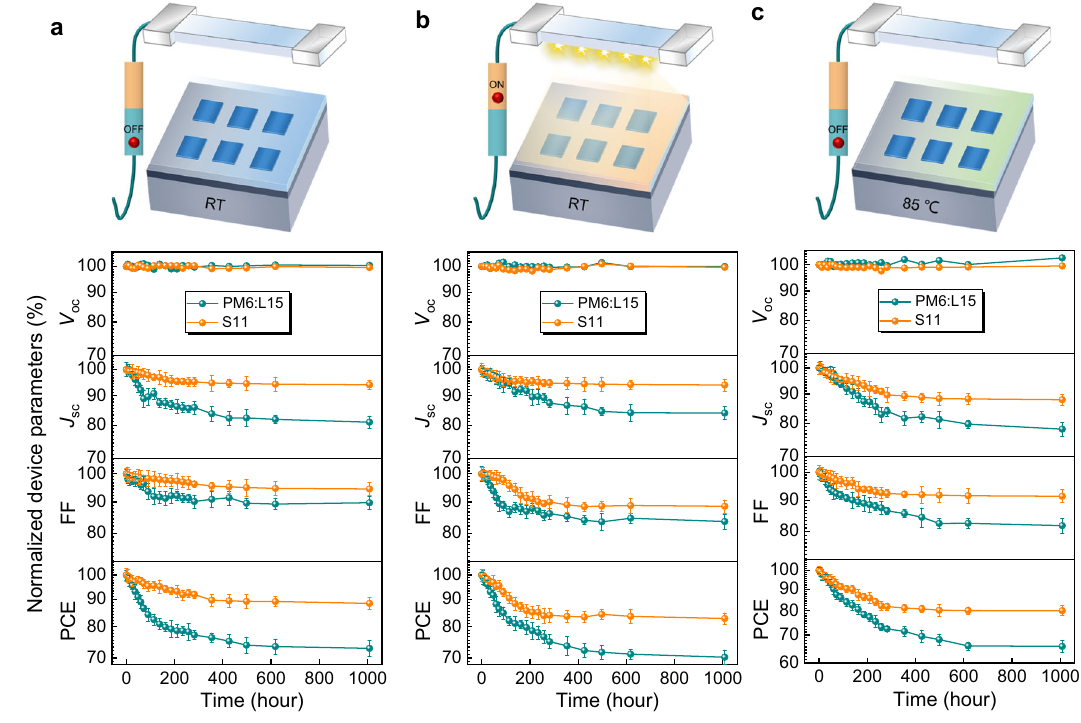
Fig. 4 | Shelf-life, light and thermal stability. Evolution of photovoltaic para- meters of the optimized two-component system PM6:L15- and multicomponent system S11-based OSCs in nitrogen atmosphere for up to 1008h storage: a under